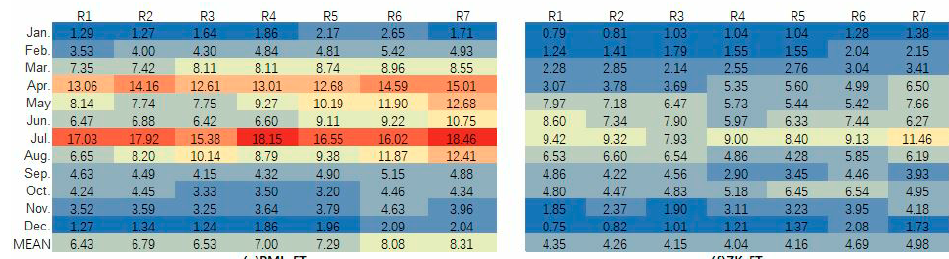
Figure 11. TCH comparison results for each sub-basin in the different months. Blue represents low uncertainty, red represents high uncertainty. The color from blue to red represents the value of uncertainty from low to high. R1—Luan River Basin; R2—Chaobai River and Jiyun River Basin; R3—Inland River Basin; R4—Daqing River Basin; R5—Ziya River Basin; R6—South Canal Basin; R7—Tuhai River and Majia River Basin.